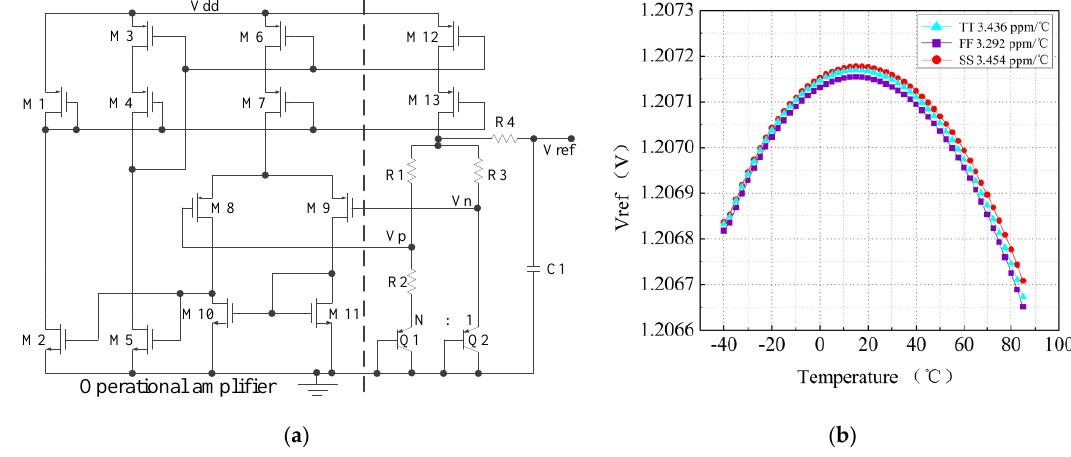
Figure 8. ( a ) Bandgap core circuit; ( b ) simulated temperature coefficient of Vref .